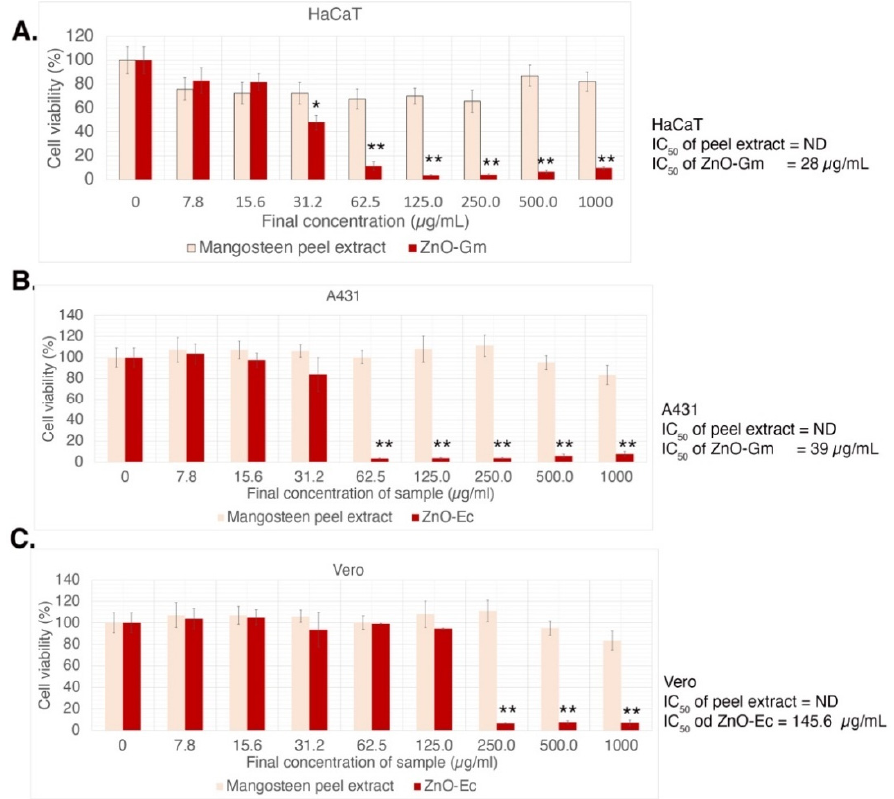
Figure 7. Cytotoxicity effects of ZnO-Gm and mangosteen extract in vitro. ( A ) HaCaT, ( B ) A431, and ( C ) Vero. ND stands for not determined. IC 50 values were shown as indicated. The data are represented in quadruplicate of mean ± SD from three independent experiments. The significant differences between the samples were shown as * p < 0.05, ** p < 0.01 (by ANOVA, Tukey’s test). On the other hand, the IC 50 values of ZnO-Ec were 79.5 µg/mL, 10.12 µg/mL, and 162 µg/mL (Figure 8).